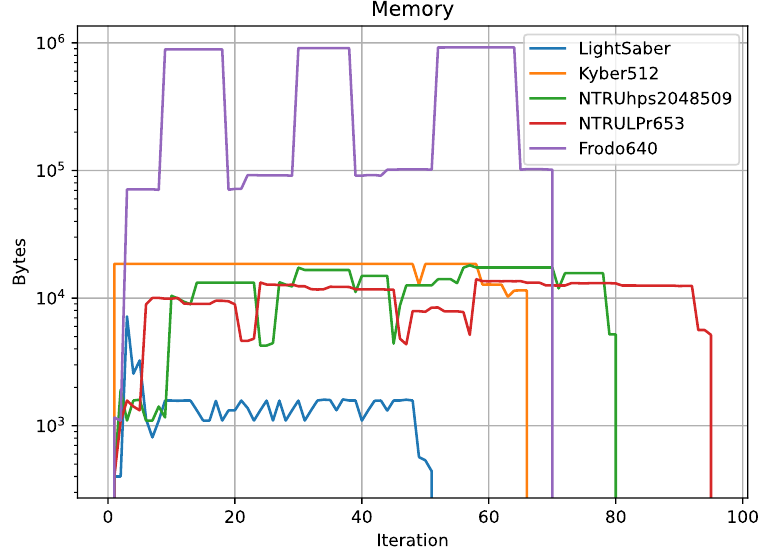
Figure 5. Memory usage over number of access for each KEM. The more access to memory, the more CPU cycles the program requires to access the RAM. LightSaber uses the memory for the least amount of time, while NTRULPr653 accesses it for the longest time. The other three fall in between. The y -axis has logarithmic scale.